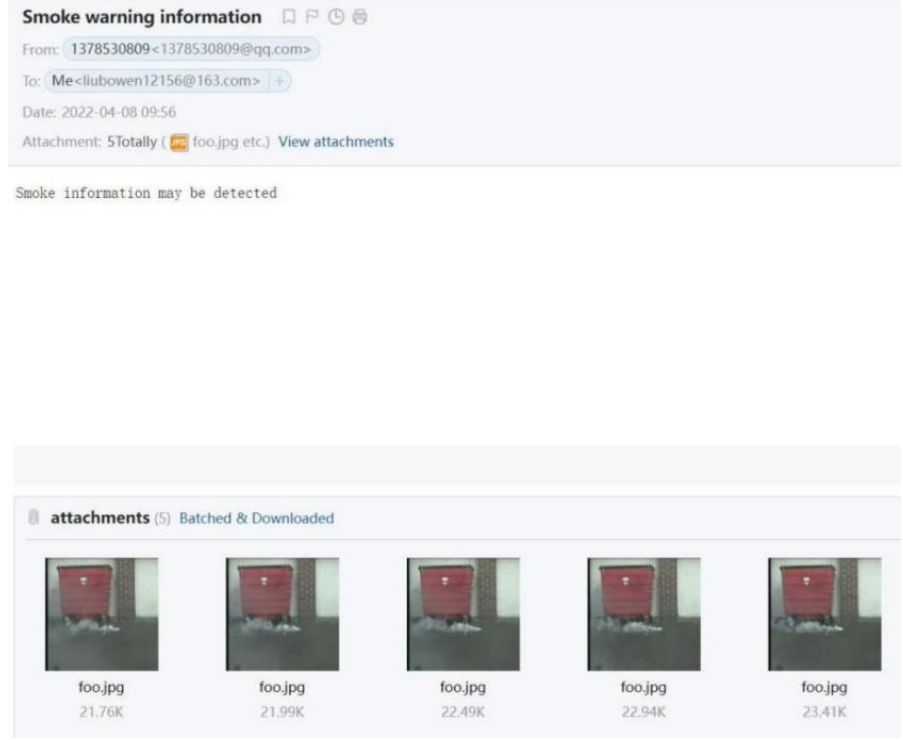
Figure 9. Email alarm interface.